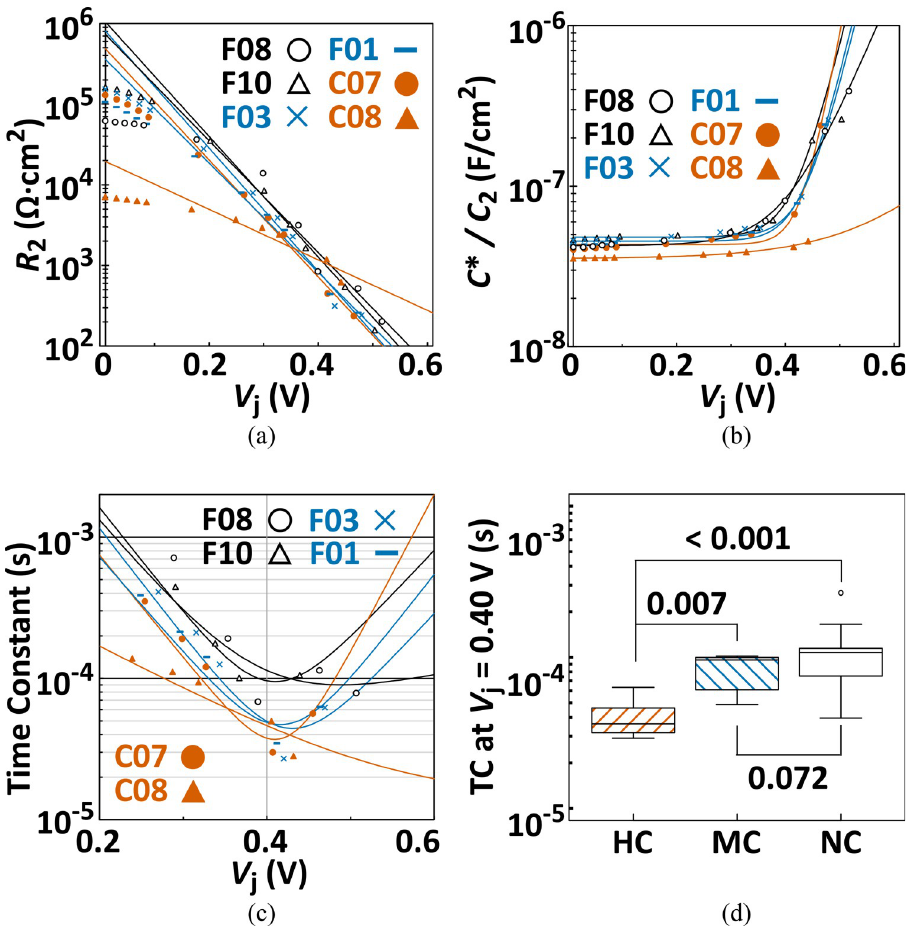
Fig 7. Estimated R 2 (a) and C � / C 2 (b) as a function of V j . Orange, blue, and black symbols correspond to those from the two PV cells representing the HC, MC, and NC cells, respectively. The time constants calculated from these R 2 and C � / C 2 are indicated in (c). Multicomparison charts for the categorized PV cells on the time constant observed at V j = 0.40 V are indicated in (d). The figures in (d) denote the respective p -values in the multicomparison, and the open circle represents